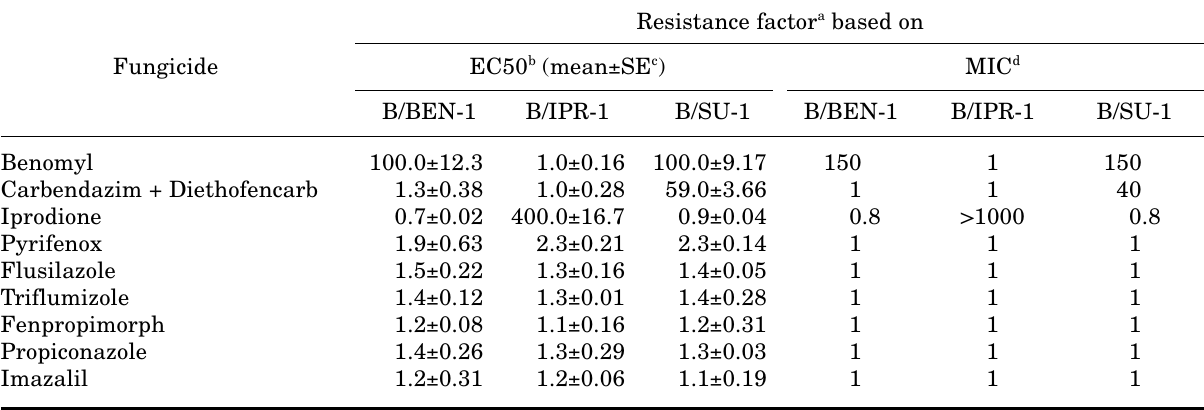
Table 2. Sensitivity of benzimidazole (mutant strain B/BEN-1), dicarboximide (mutant strain B/IPR-1) and benzim- idazole-phenylcarbamate (mutant strain B/SU-1) resistant mutant strains of Botrytis cinerea to six